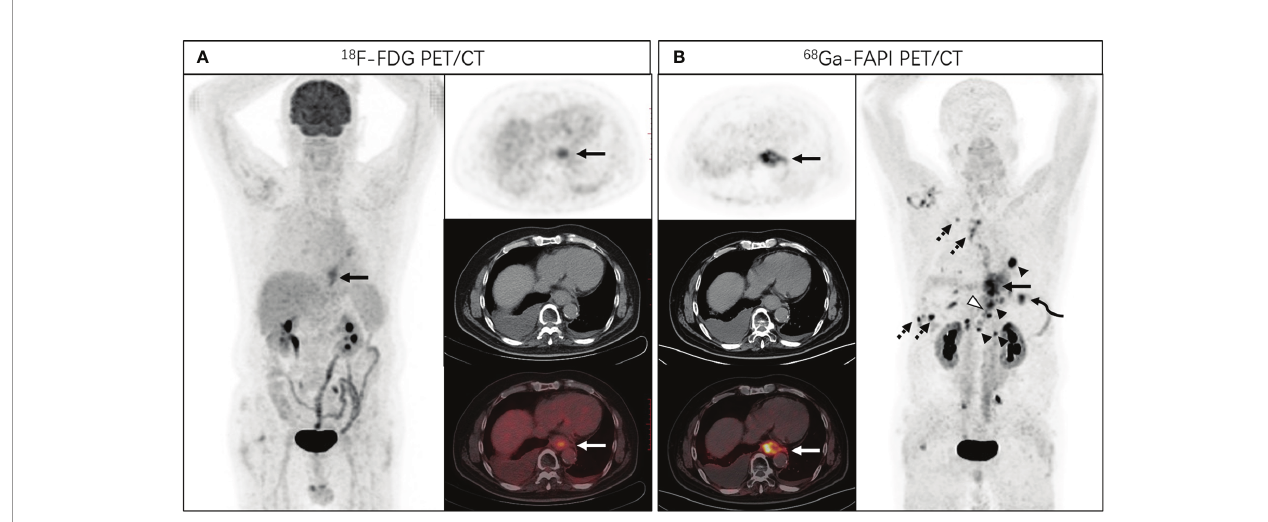
FIGURE 2 | A 68-year-old man presented with a complaint of progressive dysphagia for 3 months. Endoscopic biopsy demonstrated a poorly differentiated adenocarcinoma of the lower esophagus. [ 18 F]FDG PET/CT (A) showed increased tracer uptake in lower esophagus (SUVmax of 5.7), and no distant metastasis was identi fi ed. Subsequent [ 68 Ga]Ga-DOTA-FAPI-04 PET/CT (B) revealed intense FAPI uptake in the distal esophagus with SUVmax of 15.2 (solid arrows), with nodal metastases (arrowheads, SUVmax of 21.8), bone (hollowed arrowheads, SUVmax of 14.2), lung (curved arrowheads, SUVmax of 11.0) and pleural metastases (dotted arrows, SUVmax of